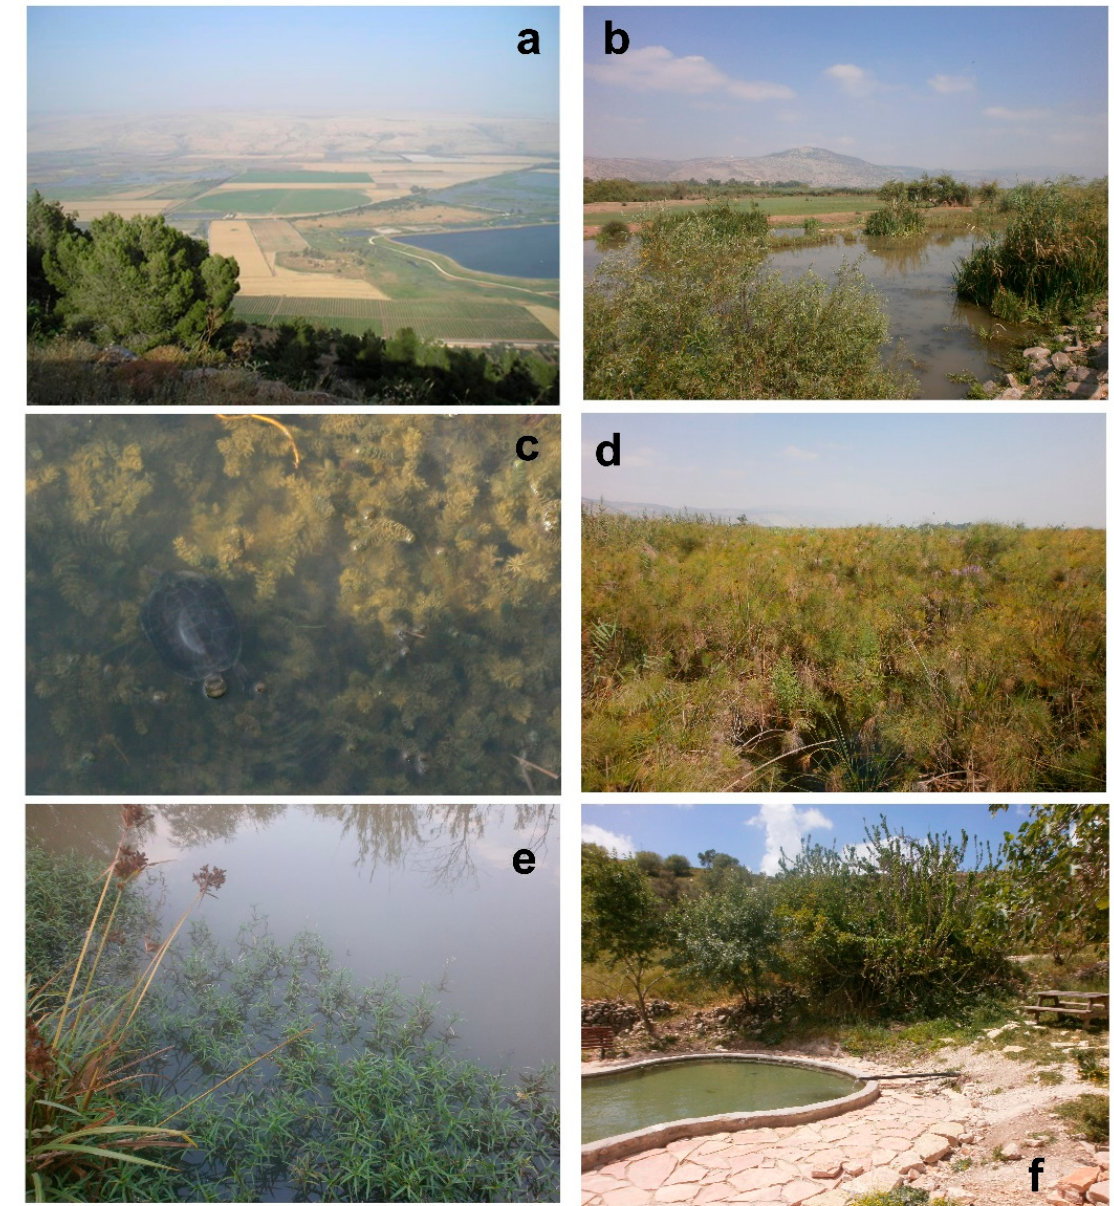
Figure 3. ( a ) Hula Valley, cultivated part, seen from Naftali Hills, E Upper Galilee; ( b ) Hula Nature Reserve; ( c ) Hula NR, Ceratophyllum demersum ; ( d ) Hula NR, Cyperus papyrus , Lythrum salicaria ; ( e )